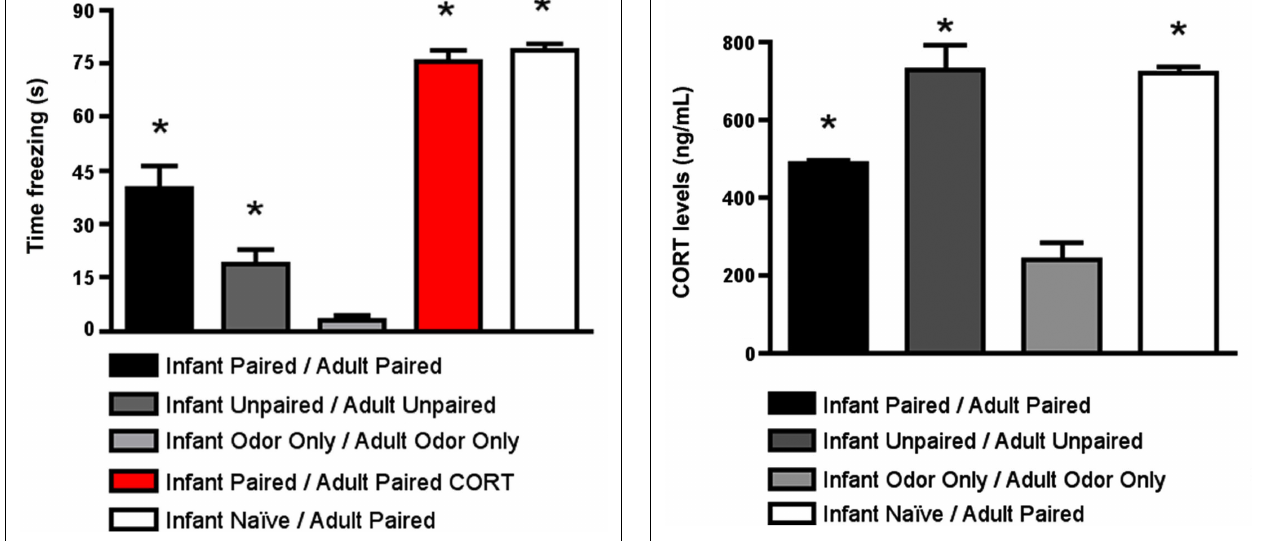
FIGURE 6 | Adult rats were reconditioned after the infant conditioning, generally using the same conditioning group in infancy and adulthood. All rats were tested the next day to measure freezing following exposure to the citral CS used in adult conditioning. Infant Paired/Adult Paired demonstrated lower levels of freezing than Infant Naïve/Adult Paired and Infant Paired/Adult Paired receiving a CORT injection ( n = 4–5/group). Asterisk represents a signifi cant difference from each of the other groups ( p < 0.05).